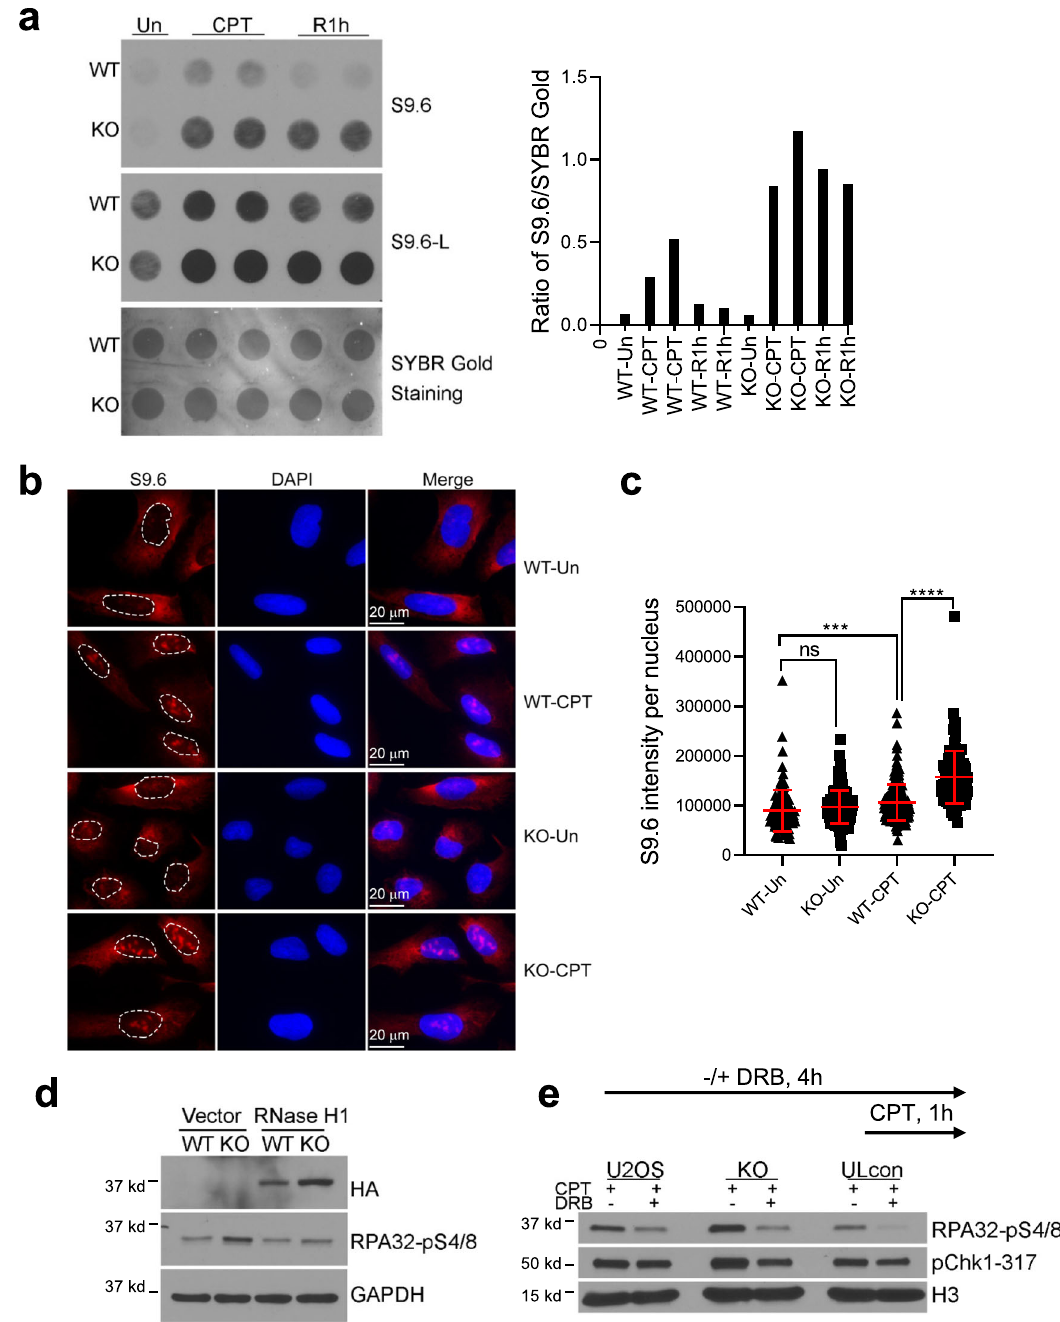
Fig. 2 Abraxas suppresses R-loop accumulation and R-loop-associated DNA end resection. a Increased R loops in Abraxas KO cells upon CPT treatment. Dot blot using S9.6 antibody of DNA from cells untreated, treated with CPT (1 μ M, 1 h), or at 1 h after release into fresh medium (left panel). Total genomic DNA was extracted and used for R-loop detection. SYBR Gold staining of the same membrane served as a loading control. S9.6 intensity was measured by ImageJ and normalized to loading control for quanti fi cation (right panel). b S9.6 immuno fl uorescence staining in WT and Abraxas KO cells. Cells untreated or treated with CPT (1 μ M, 1 h) were pre-extracted with 0.2 % Triton X-100 before fi xation. c S9.6 nuclear intensity was quanti fi ed by ImageJ software and plotted as mean ± SD for WT-Un ( n = 117), KO-Un ( n = 133), WT-CPT ( n = 194), and KO-CPT ( n = 121) cells examined. One-way ANOVA Kruskal – Wallis test was used for statistical analysis. *** p = 0.0002, **** p < 0.0001. d RNaseH1 expression reduced RPA32-pS4/8 levels in Abraxas KO cells treated with CPT. Cells transfected with vector or HA-tagged RNaseH1 were treated with CPT. RNaseH1 expression was detected by HA antibody. e Addition of transcription inhibitor DRB reduced RPA32-pS4/8 levels in Abraxas KO cells. Then, 20 μ M 5, 6-dichloro-1- β -d-ribofuranosylbenzimidazole (DRB) was added 3 h before CPT treatment (1 μ M, 1 h). See also Supplementary Fig. 2.